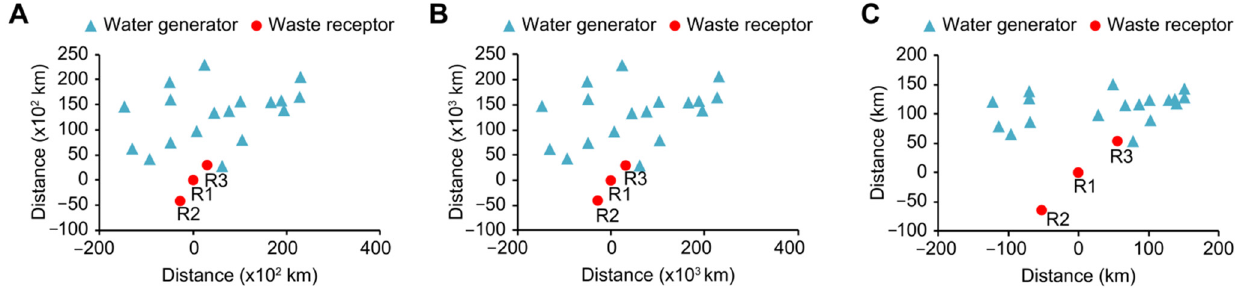
Figure 4. Map of waste generators and waste receptors R1–R3 for Baseline Scenario ( A ), Scenario 2a ( B ) and Scenario 2b ( C ). Distance is expressed as longitudinal distance (X-axis) and latitudinal distance ( Y -axis) with respect to the R1